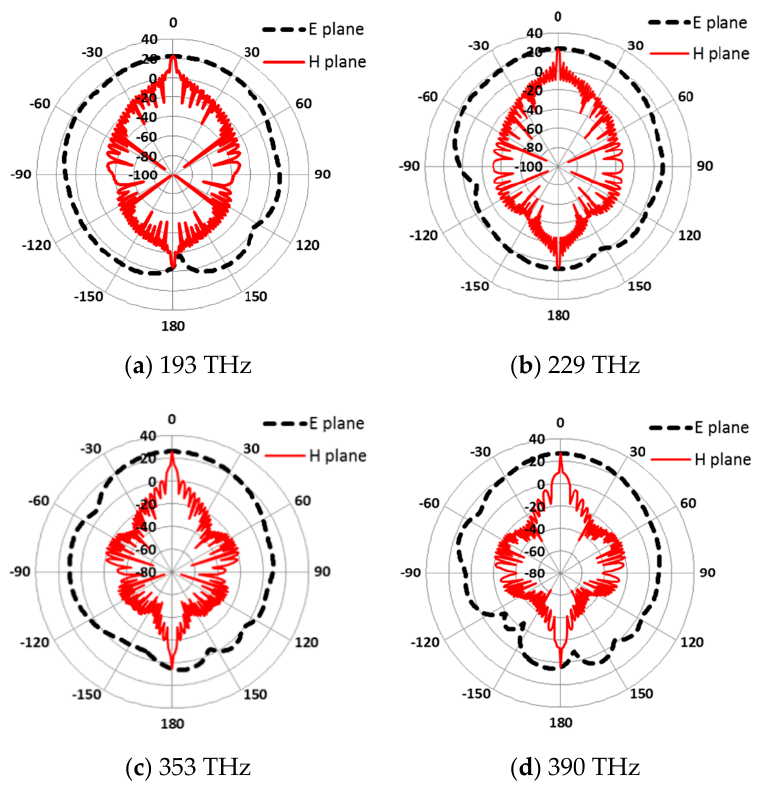
Figure 18. The 64 × 1 array gain plots in the E and H planes at ( a ) 193 THz; ( b ) 229 THz; ( c ) 353 THz; ( d ) 390 THz.